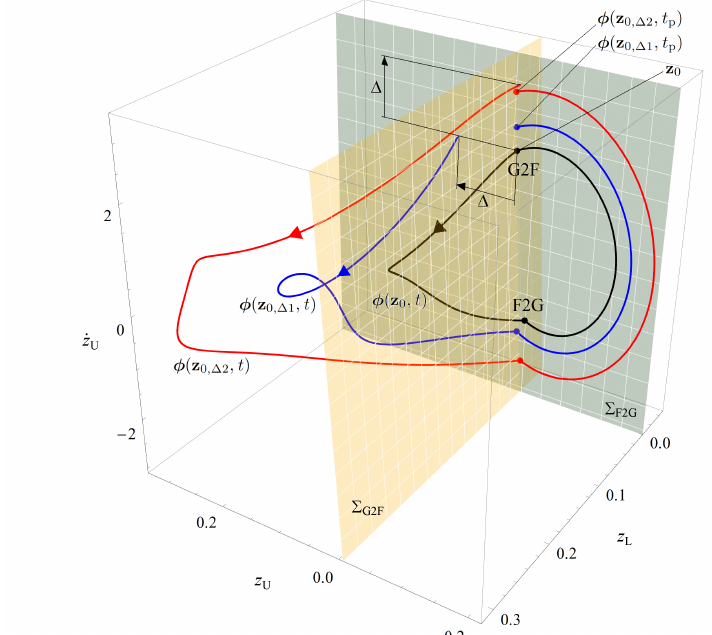
Figure 3. The switching surfaces, the periodic orbit and the perturbed trajectories. The dots indicate the intersection with switching surfaces Σ G2F and Σ F2G . Note: state variable ˙ z 2 has a jump after reaching Σ F2G , which cannot be seen explicitly